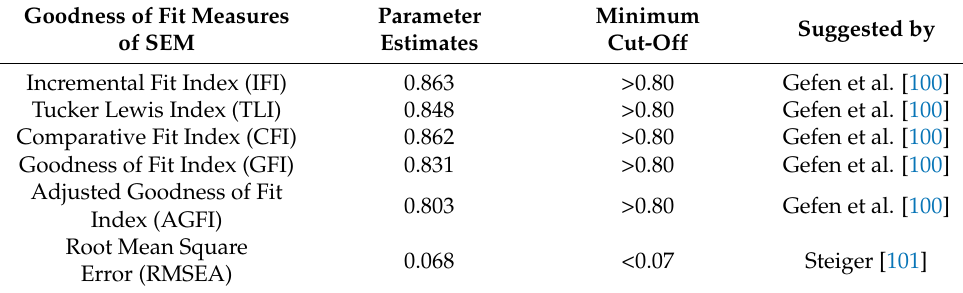
Table 5. Model Fit.